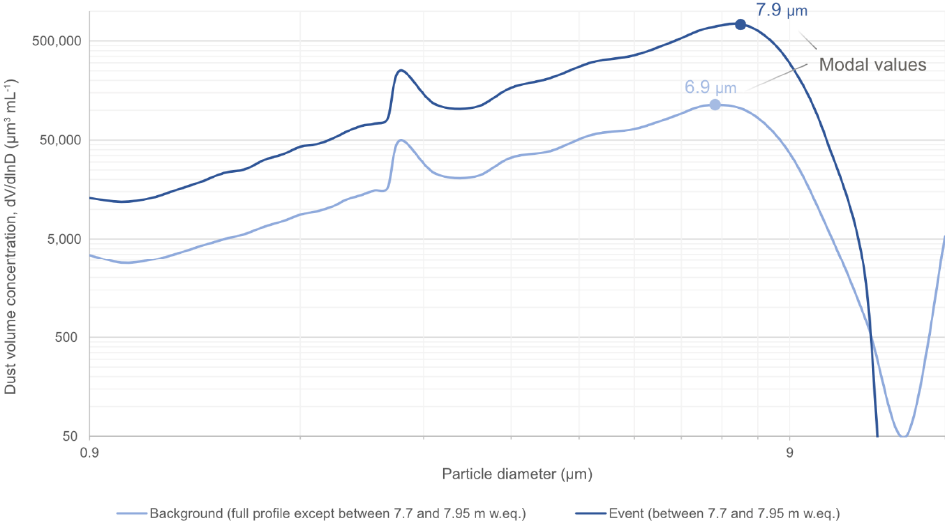
Figure 6. Particle size distribution of dust, defined as insoluble particulate matter, in the Young Island ice core; dV/dlnD = derivative of the total dust volume (V) with respect to the natural logarithm of the particle diameter (D) for each bin.